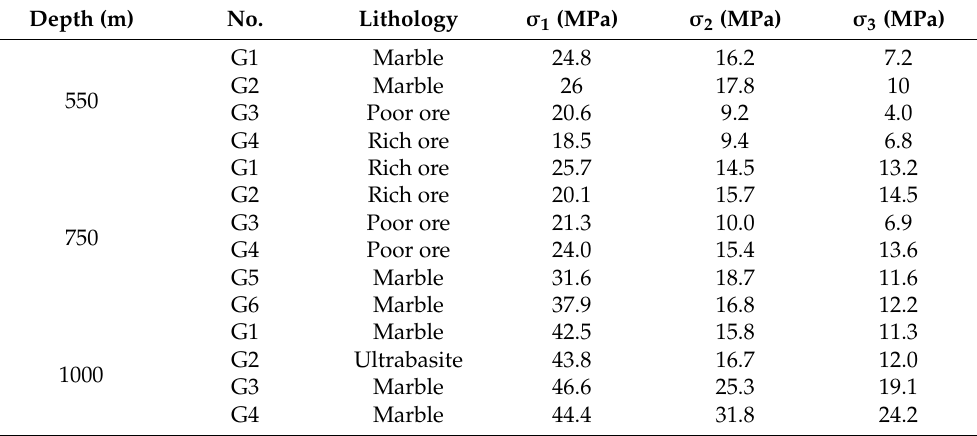
Table 1. Ground stress parameters.